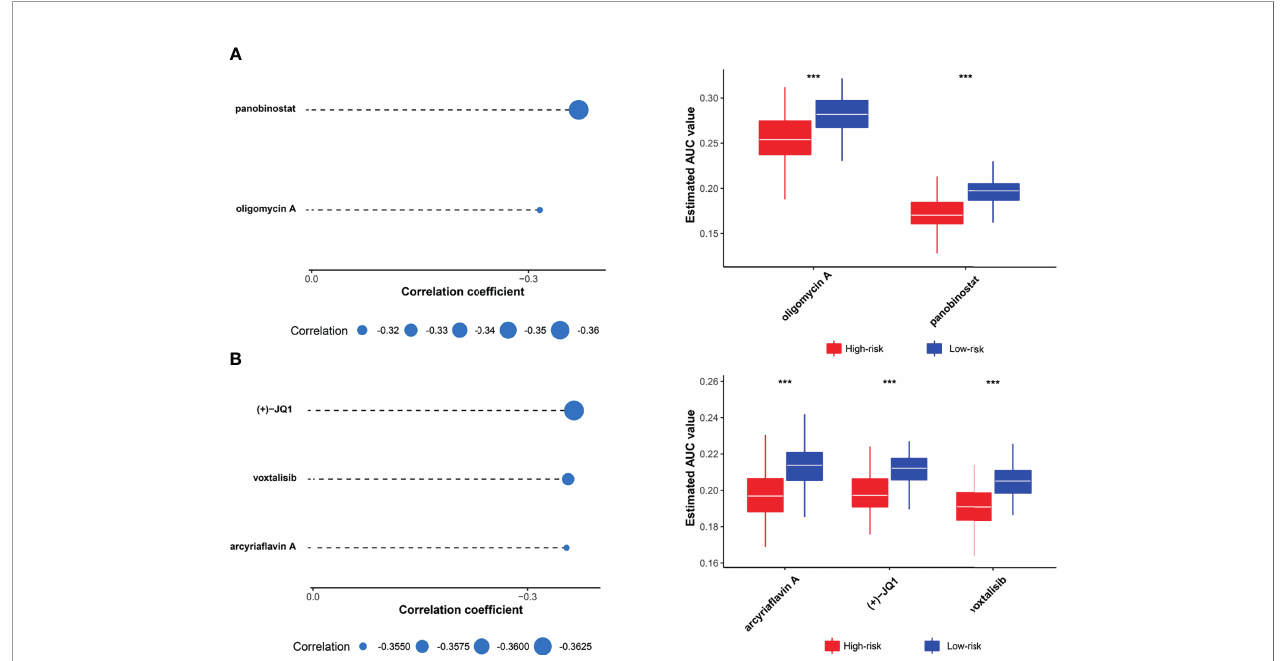
FIGURE 6 | Identi fi cation of candidate drugs with higher drug sensitivity in high risk score patients. (A) The results of Spearman ’ s correlation analysis and differential drug response analysis of two CTRP-derived compounds. (B) The results of Spearman ’ s correlation analysis and differential drug response analysis of three PRISM- derived compounds. Note that lower values on the y-axis of box plots imply greater drug sensitivity. The statistical signi fi cance of pairwise comparisons is annotated with symbols in which *** represent P ≤